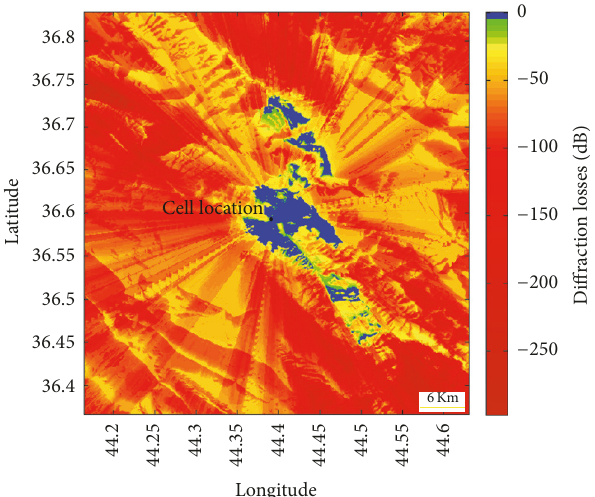
Figure 7: Diffraction loss thematic map view (area = 4029 Km 2 ).